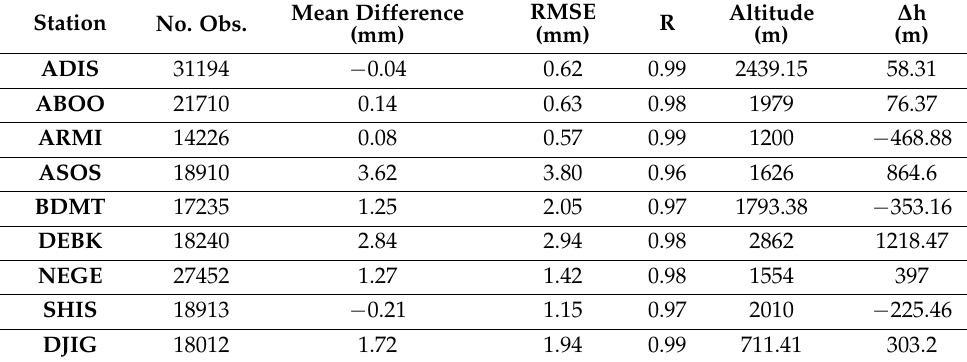
Table 3. GAMIT-PWV compared to ERA5-PWV (ERA5-PWV used as reference). The different columns denote the number of ERA5-PWV and GAMIT-PWV observation pairs, the mean differences between GAMIT-PWV and ERA5-PWV (GAMIT-PWV minus ERA5-PWV) in mm, the Root Mean Square Errors (RMSE) in mm, the correlation coefficient R, the altitude of the GPS station in m, and the height difference ∆ h in m between GPS receiver antenna height and ERA5 model grid surface height.